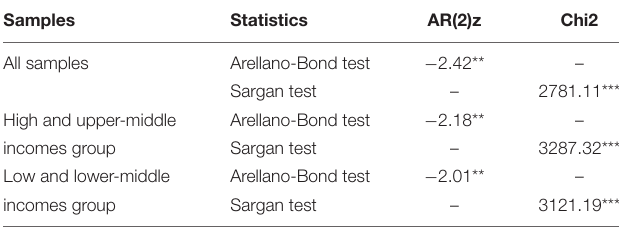
TABLE 9 | Diagnostic test results for GMM estimation.